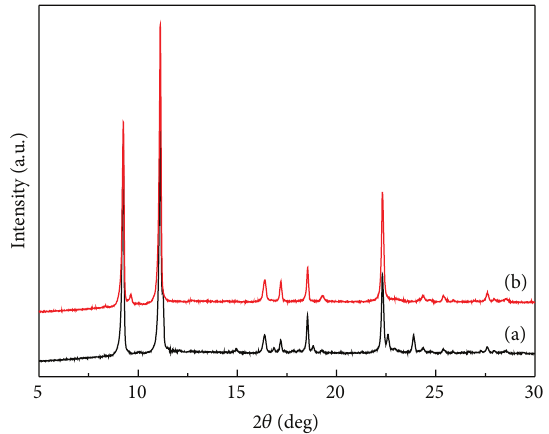
Figure 1: XRD patterns of MIL-53 (Fe) samples with different crystallization time. (a) 1 day, (b) 3 days.